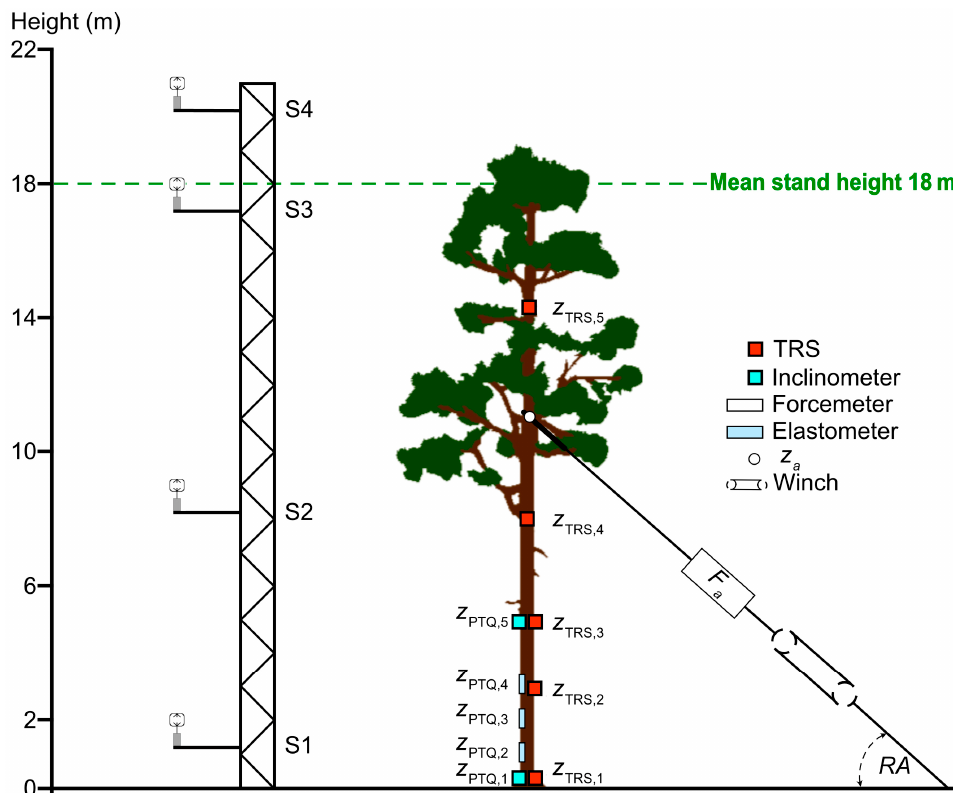
Figure 3. System used for measuring stem tilt of B1 to B35 during static, non-destructive pulling tests. The stem tilt was measured with five Tree Response Sensors (TRS) at heights z TRS,1 = 0.1 m (stem base), z TRS,2 = 1/7 H , z TRS,3 = 5 m, z TRS,4 = 3/7 H (only B1 to B5), and z TRS,5 = 5/7 H (only B1 to B5), and two PiCUS TreeQinetic (PTQ) inclinometers at z PTQ,1 = 0.1 m and z PTQ,5 = 5 m. Three PTQ elastometers at z PTQ,2 = 1 m, z PTQ,3 = 2 m, and z PTQ,4 = 3 m measured strain in the marginal wood